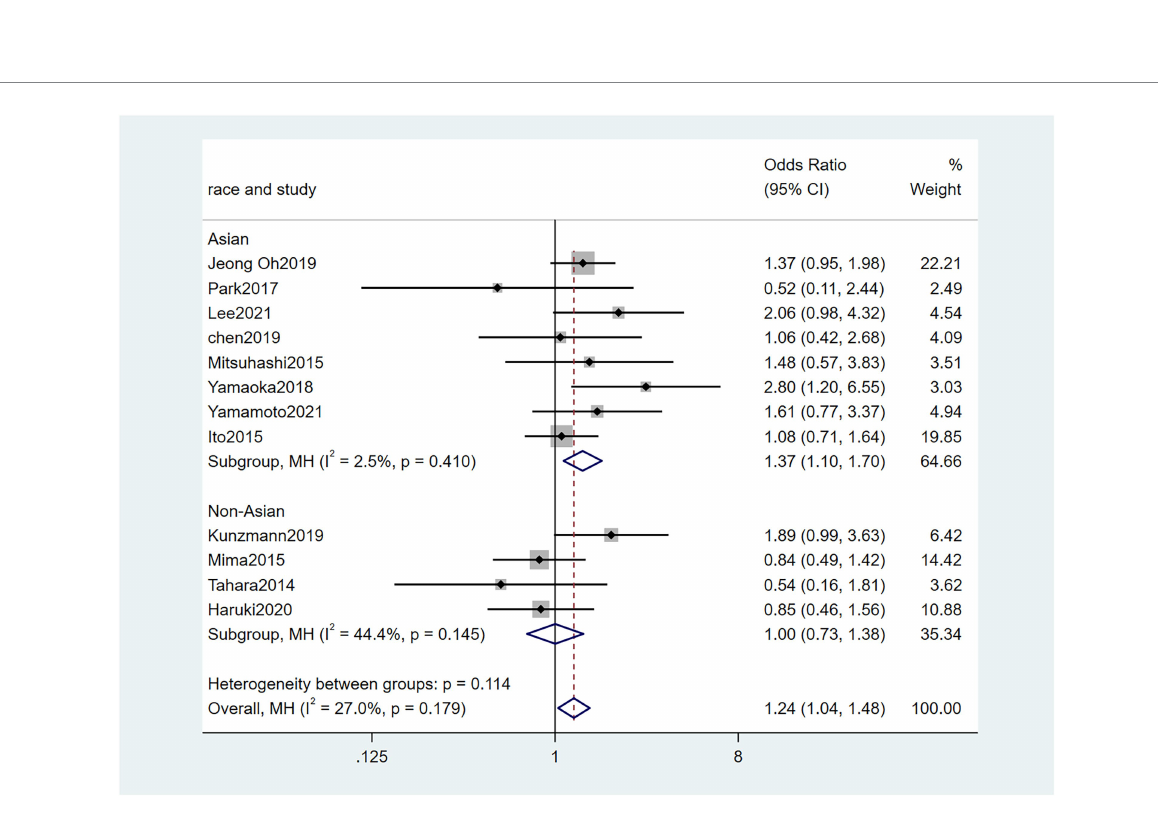
FIGURE 9 Forest plot of the relationship between Fusobacterium nucleatum and KRAS mutation in